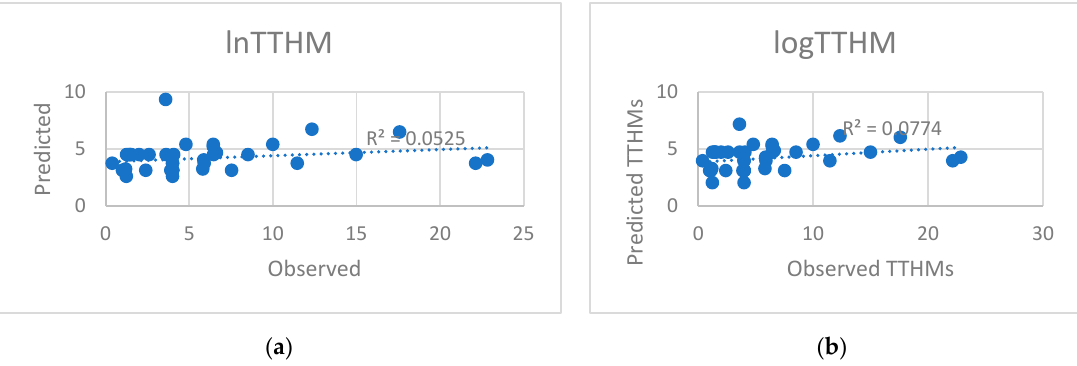
0510 R² = 0.0525 Figure 5. Predicted vs Observed values for ( a ) model (2); ( b ) model (3). Figure 5. Predicted vs Observed values for ( a ) model (2); ( b ) model (3). Water 2020 , 12 , x FOR PEER REVIEW R² = 0.5673 Figure 6. Predicted vs Observed values for ( a ) model (4); ( b ) model Figure 6. Predicted vs Observed values for ( a ) model (4); ( b ) model (5).